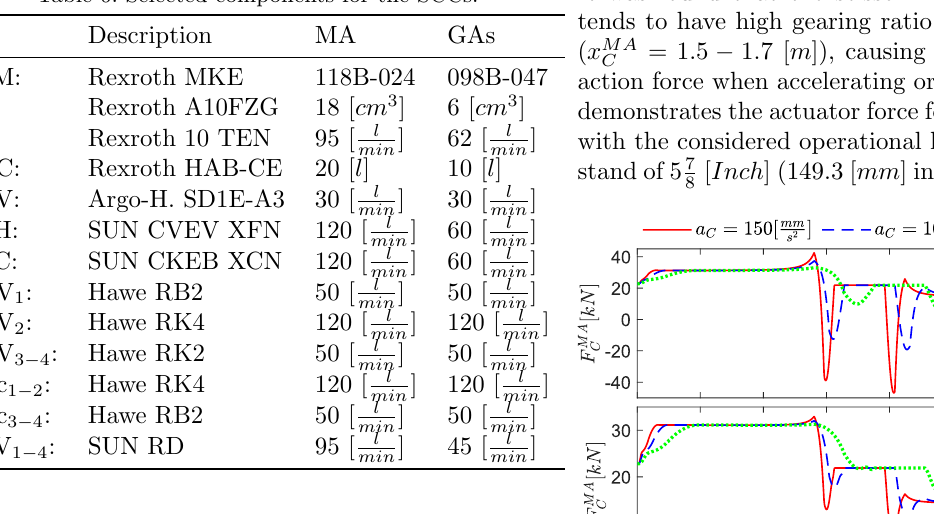
Table 6: Selected components for the SCCs.